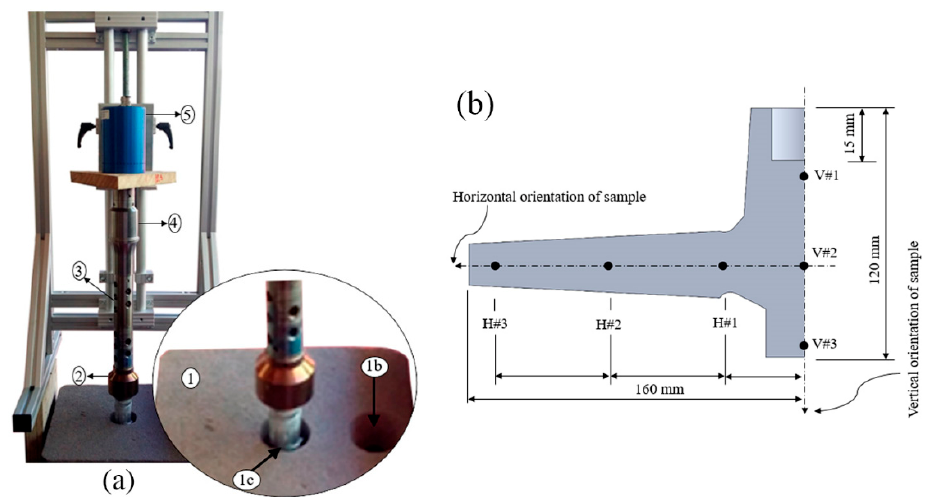
Figure 1. ( a ) Experimental setup: (1) sand mold, (1b) pouring basin, (1c) feeder, (2) acoustic radiator, (3) waveguide, (4) booster, (5) transducer 20 kHz; ( b ) Geometric model where V#1 to V#3 correspond to the positions for sample characterization (Note: mirrored symmetry).